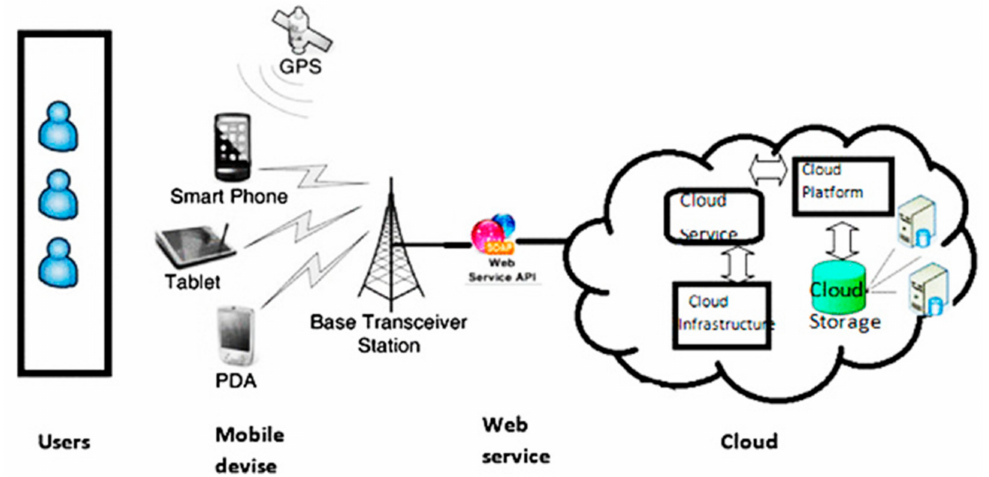
Figure 4. Mobile cloud computing for users, mobile devices, web services, and cloud